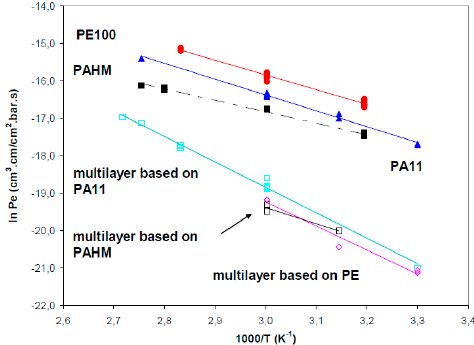
Figure 1. Arrhenius curves for 3 polymers [27].